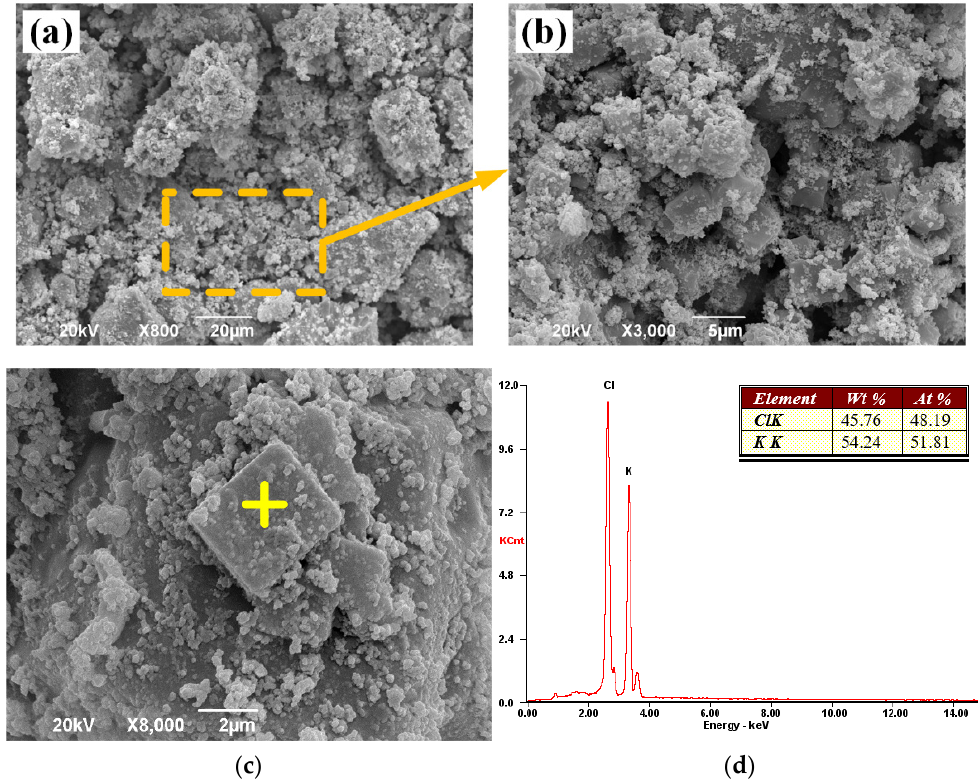
Figure 3. ( a – c ) SEM images and ( d ) EDS analysis of iron ore sintering dust.